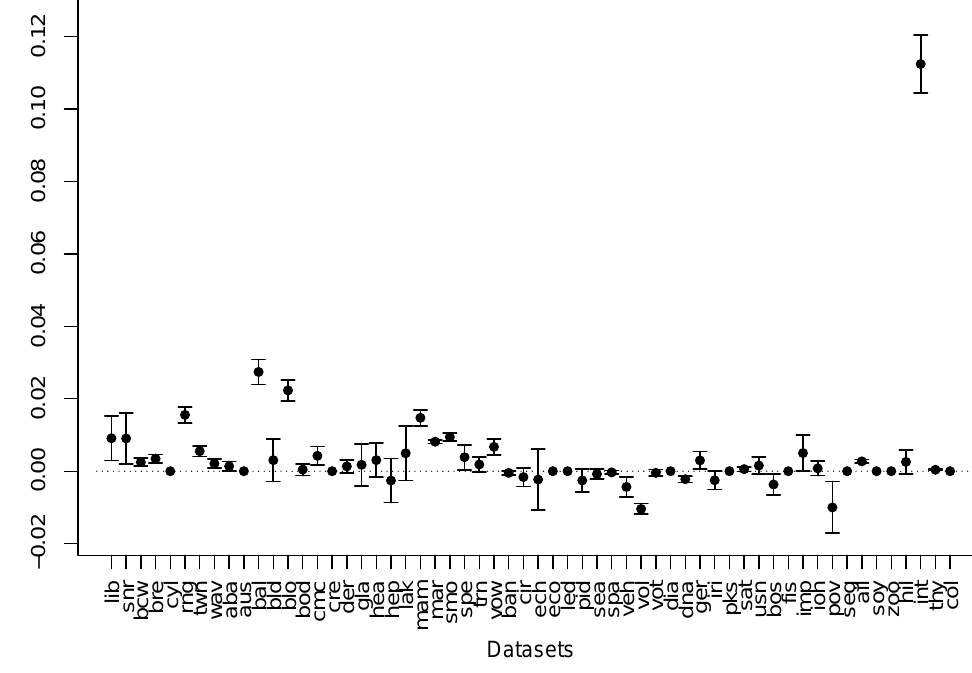
Figure 7. Confidence intervals of accuracy differences using the estimated m and the default m . The difference is significant when the confidence interval does not contain